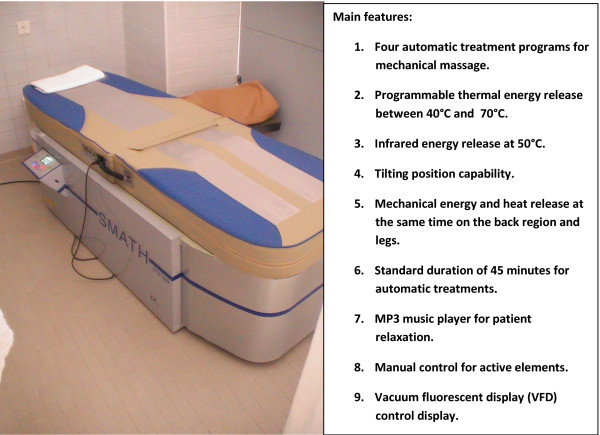
The SMATH® System.